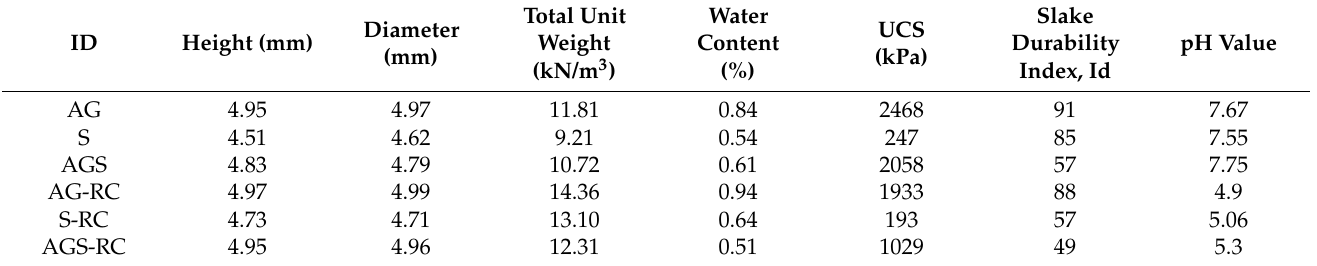
Table 4. Test results of all